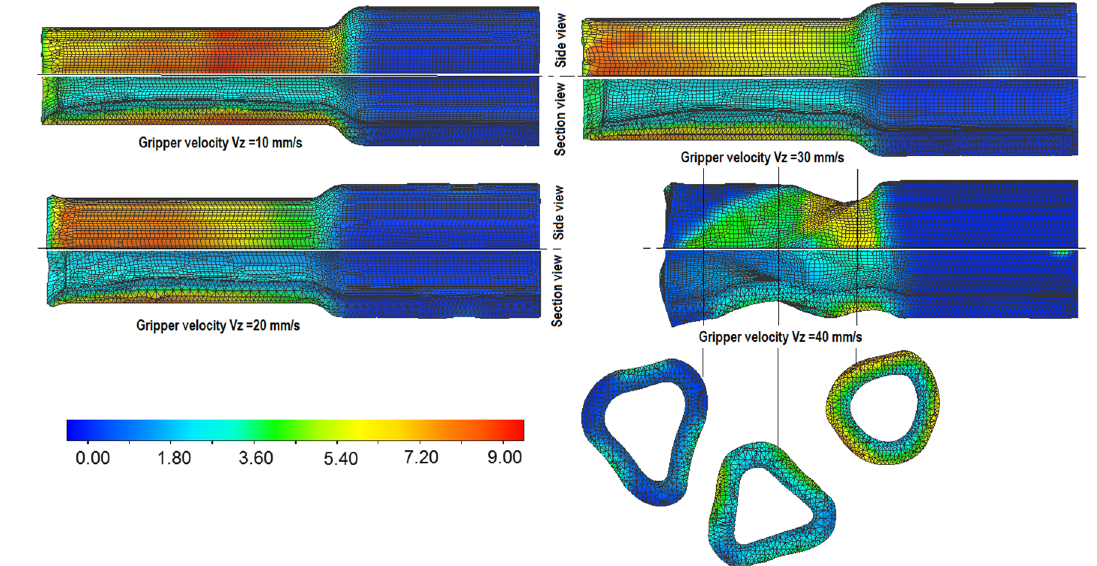
Figure 5. The progression of shapes and effective strain distributions in hollow shafts skew rolled with different gripper velocity.